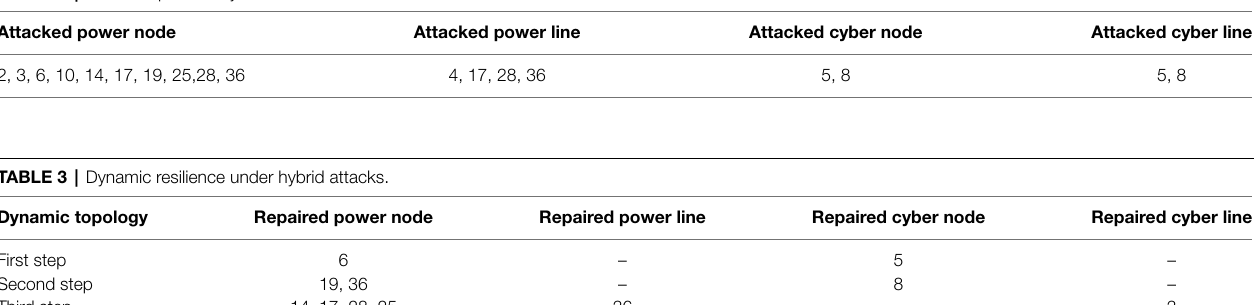
TABLE 2 | Attacked parts of hybrid attacks.